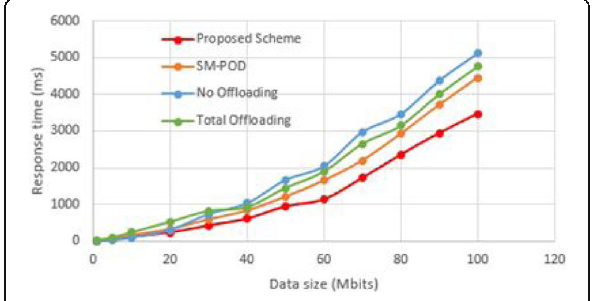
Fig. 7 Application response time